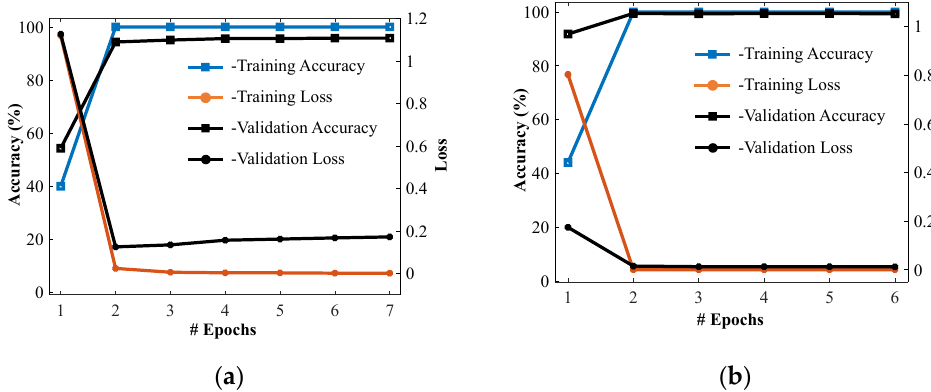
Figure 4. Training/validation accuracies and losses of the proposed ( a ) DS-Net and ( b )